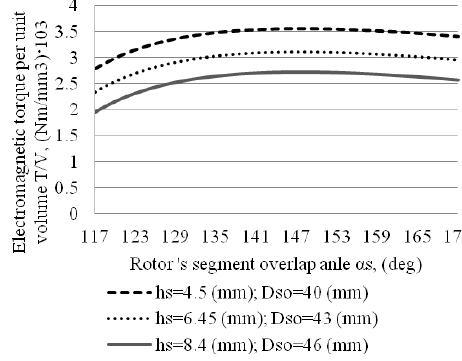
Fig. 5. Maximum value of electromagnetic torque per unit volume according to overlap angle of rotor’s segment.